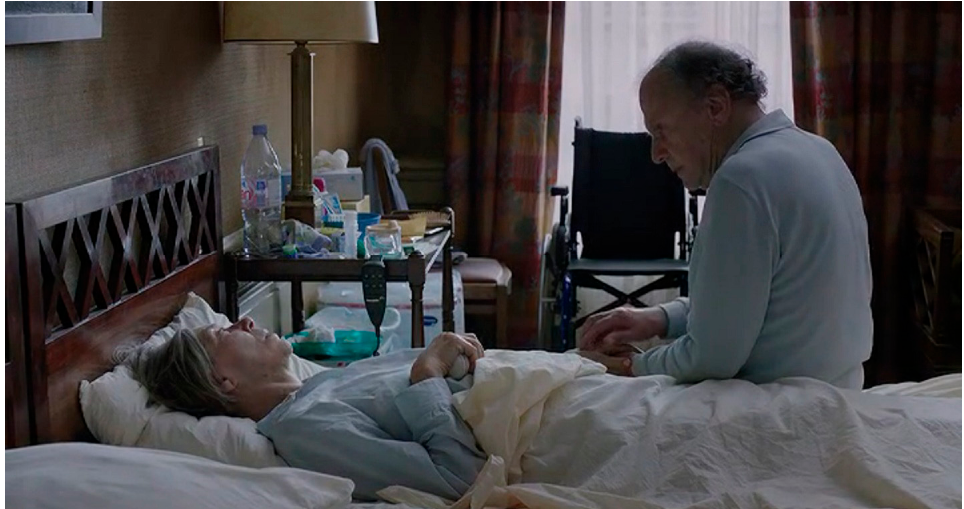
Figure 7. The couple reaches a breaking point.